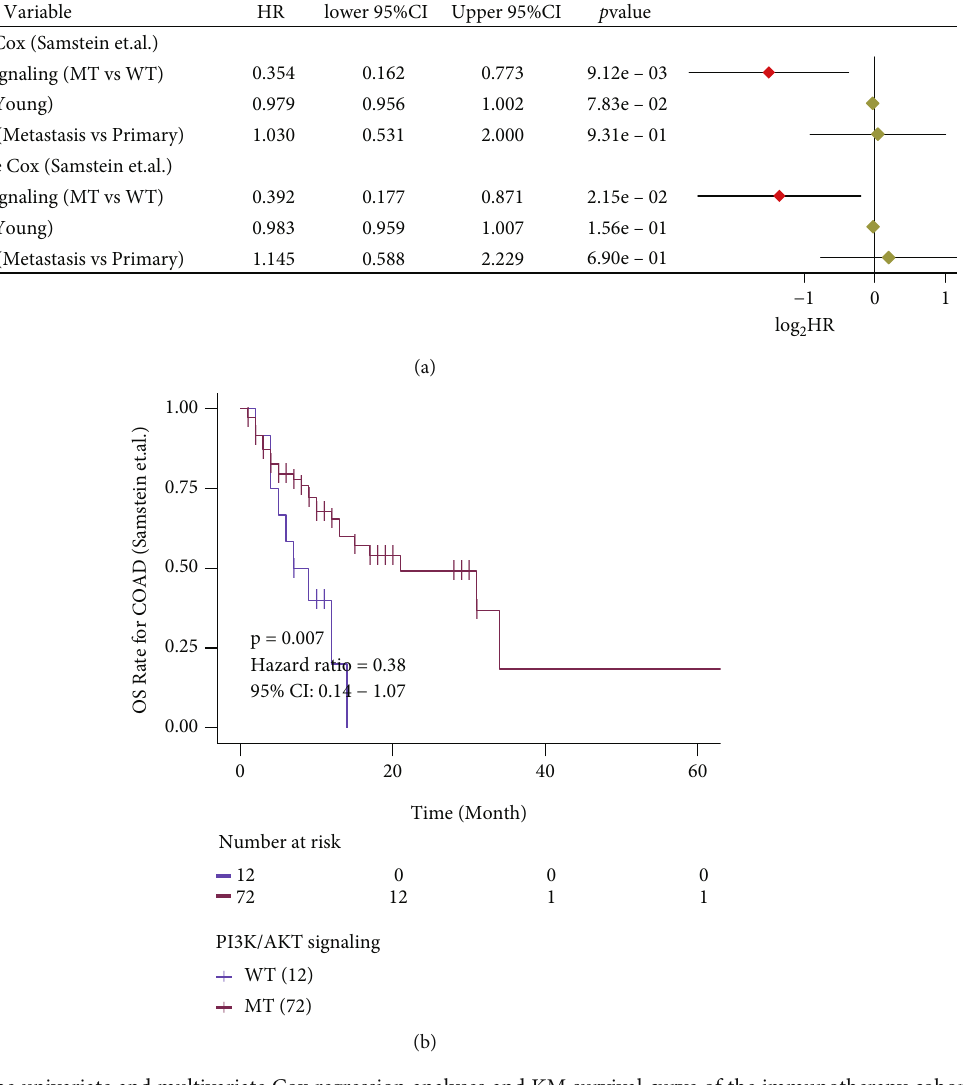
Figure 1: Results of the univariate and multivariate Cox regression analyses and KM survival curve of the immunotherapy cohort. (a) The results of the univariate and multivariate regression analyses are displayed with a forest map. The main part of the forest map is used to show the HR and 95% con fi dence intervals. The factors associated with good prognosis are HR < 1 , and those associated with poor prognosis are HR > 1 . (b) The KM curve of the immunotherapy cohort (Samstein et al.) predicted OS ( P < 0 : 01 , log-rank